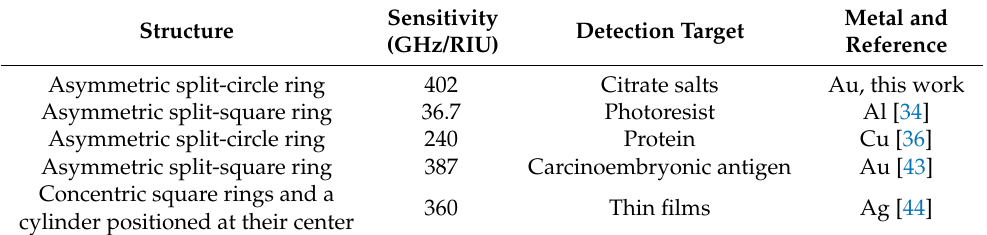
Table 3. Sensitivity comparison between the proposed metal metamaterial with widely used ones.